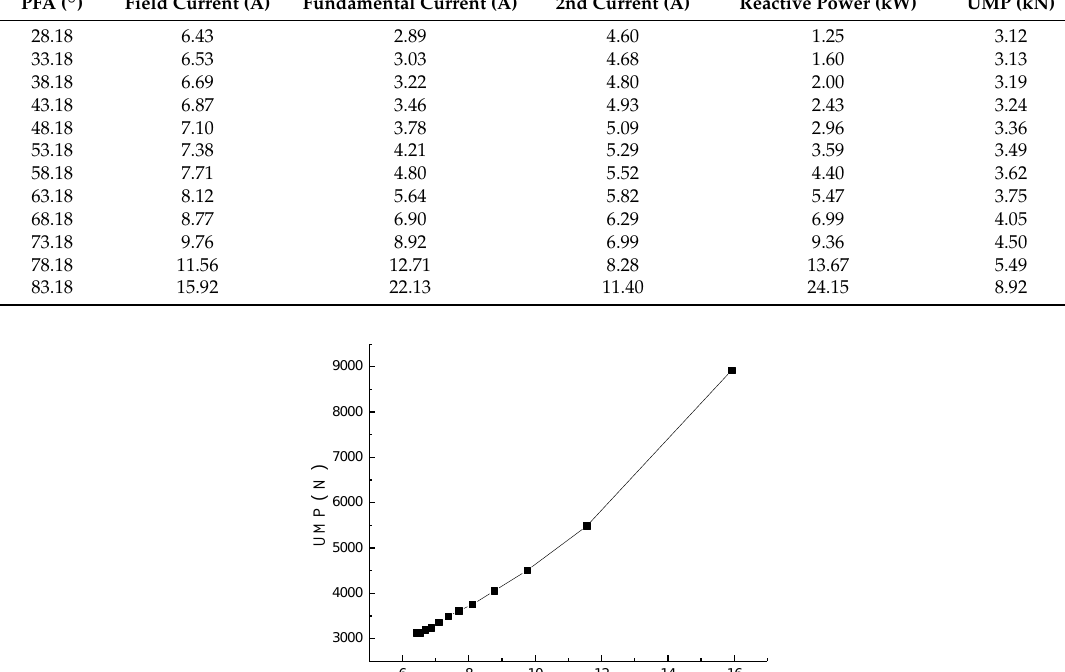
Table 8. Operation data of A1552 model machine field winding on taps 2–4 short circuit.